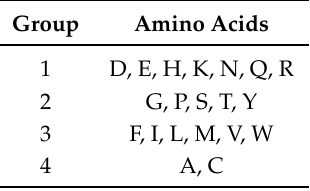
Table 2. The encoding of amino acids with the best sensitivity.